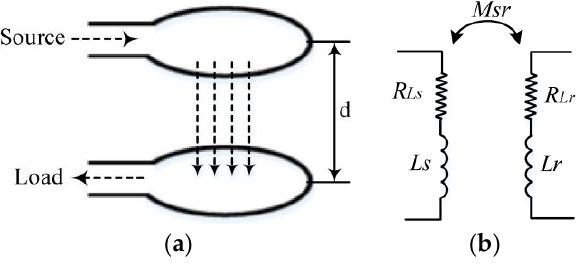
Figure 4. Proposed system with ( a ) source/load and ( b ) equivalent circuit model.